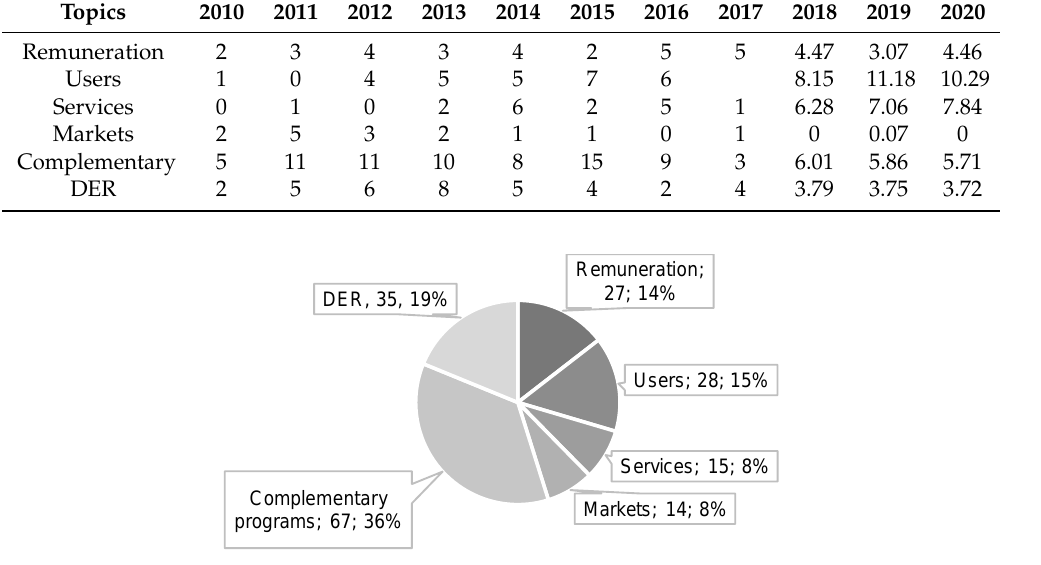
Figure 2. DR circular diagram.